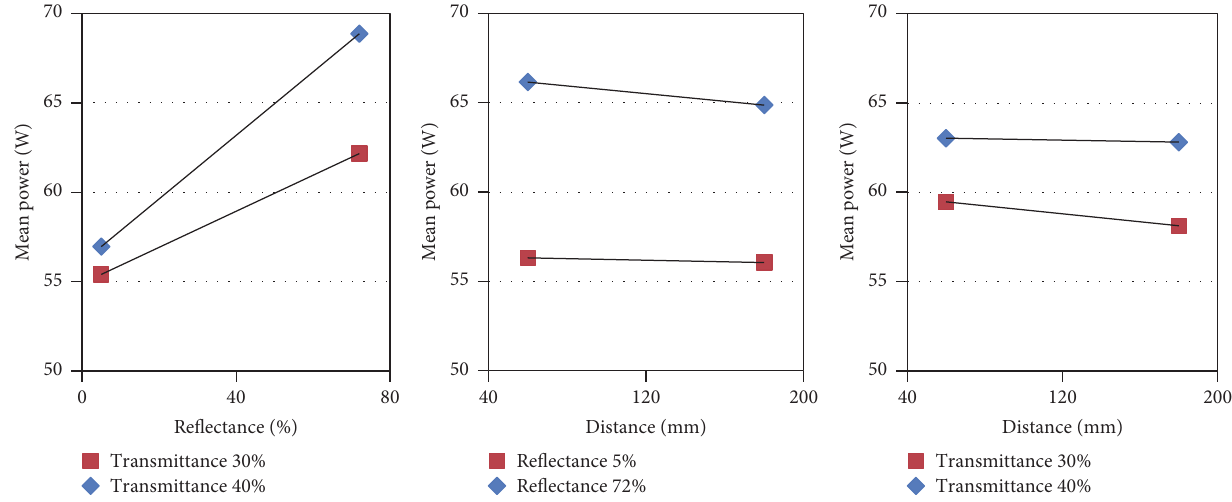
Figure 11: Interaction effect according to the design